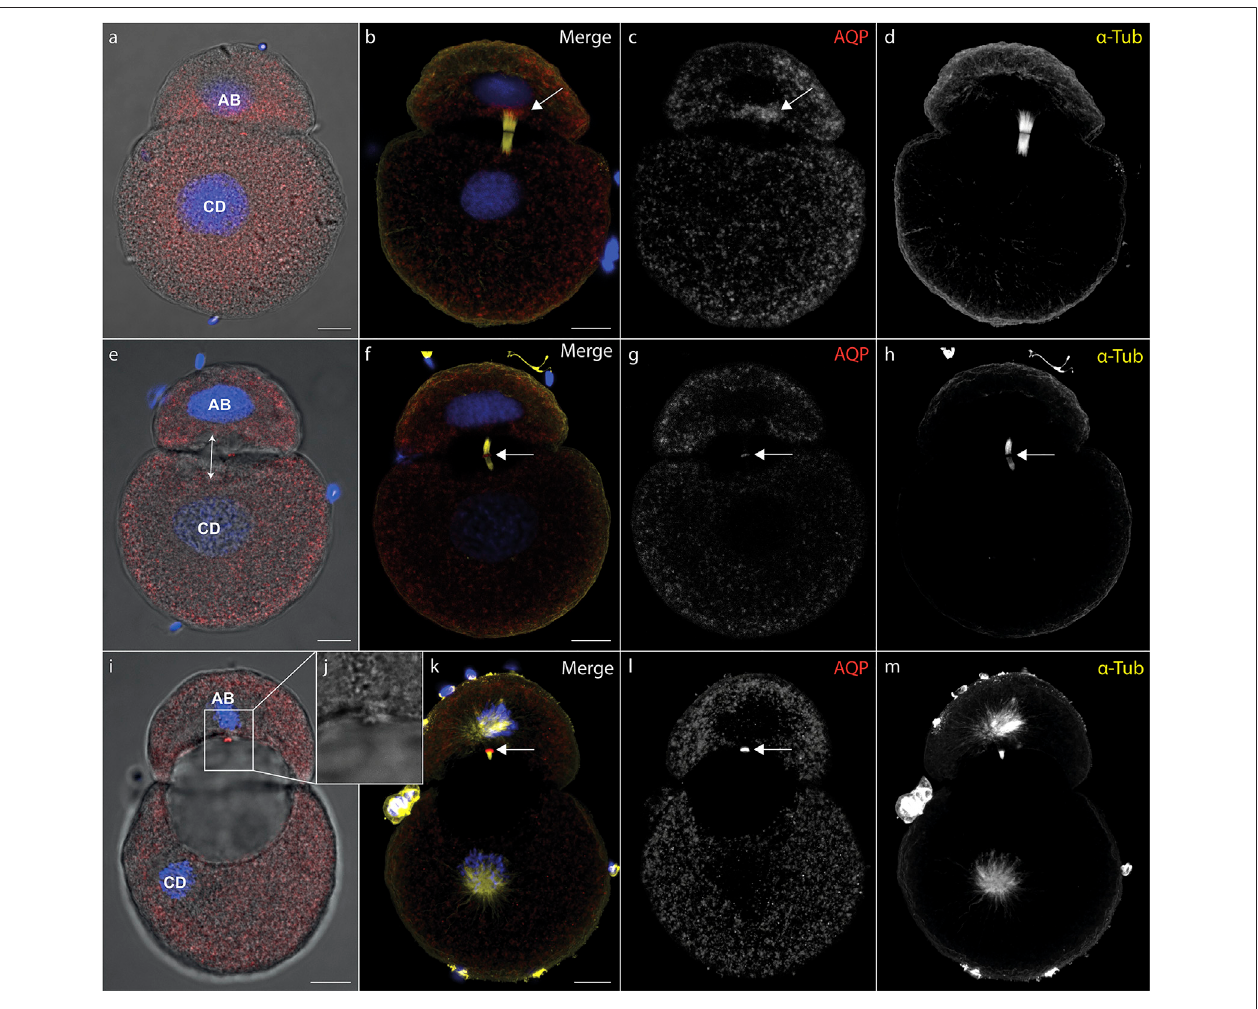
FIGURE1 | Recruitmentofmidbodyaquaporin and formation ofthe fi rst cleavage cavity. (A – l) Maximum intensity projections of Dreissena rostriformis embryos at 1 hpf (A – D) , 1.25 hpf (E – H) and 1.5 hpf (I – L) . Hoechst labeling of nuclei is shown in blue, Dro-lt-AQP1 immuno fl uorescence is shown in red (A,B,E,F,I,K) or grey-scale (C,G,L) and acetylated/tyrosinated alpha-tubulin immuno fl uorescence is shown in yellow (B,F,K) or grey-scale (D,H,M) . AB and CD blastomere morphology and cleavage cavity expansion are shown in overlays of bright fi eld images with Dro-lt-AQP1 immuno fl uorescence (A,E,I) . Arrows in (B,C) indicate Dro-lt-AQP1 accumulation at the cytokinetic bridge. Arrows in (F,G,H,K,L) indicate the location of the Dro-lt-AQP1 immunoreactive midbody. The double-headed arrow in (E) indicates the direction of cleavage cavity expansion. (J) Bright fi eld close-up of the Dro-lt-AQP1 immunoreactive midbody remnant shown in (I) . Scale bars, 10 μm.